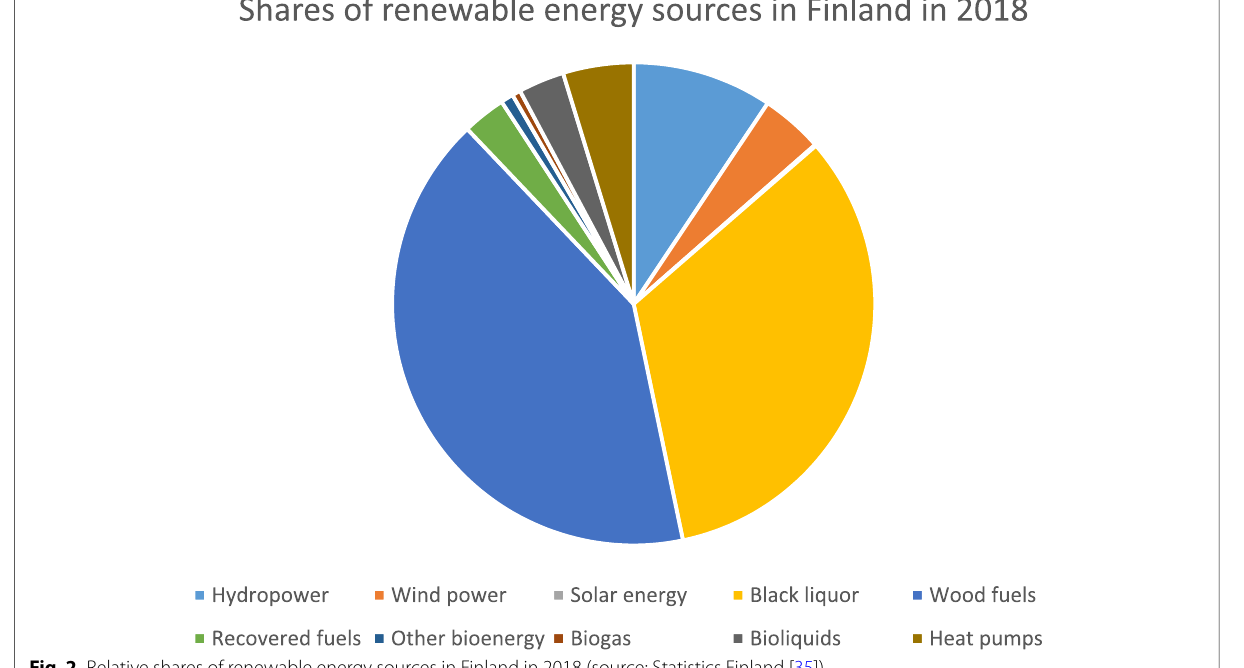
Fig. 2 Relative shares of renewable energy sources in Finland in 2018 (source: Statistics Finland